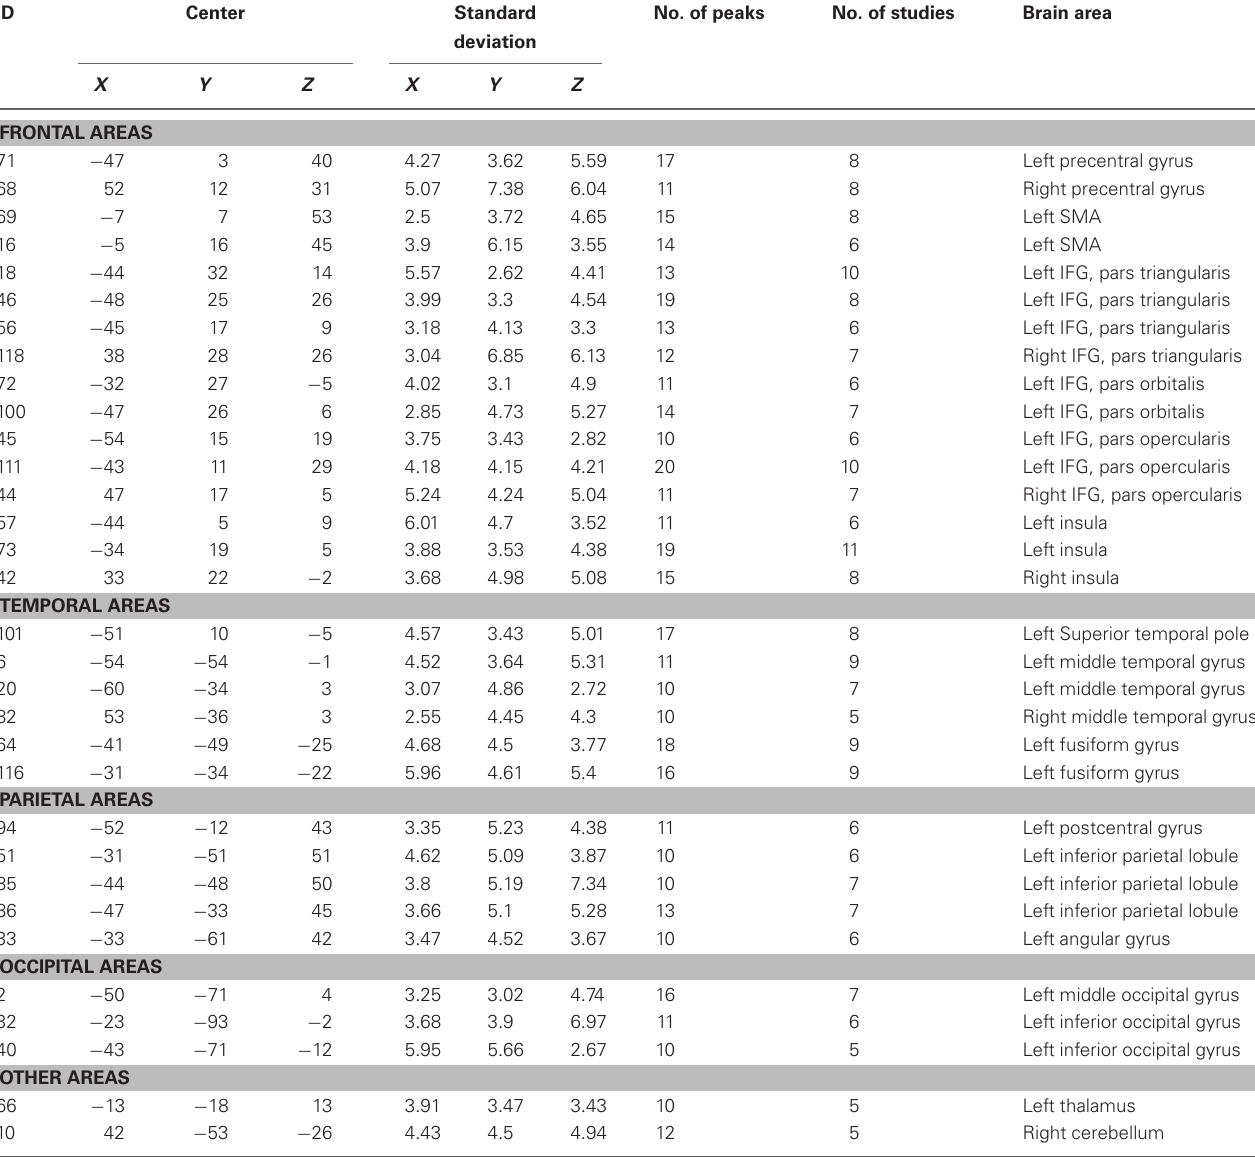
Table 2 | List of the clusters that include at least 10 activation peaks from at least five different studies obtained through the application of the